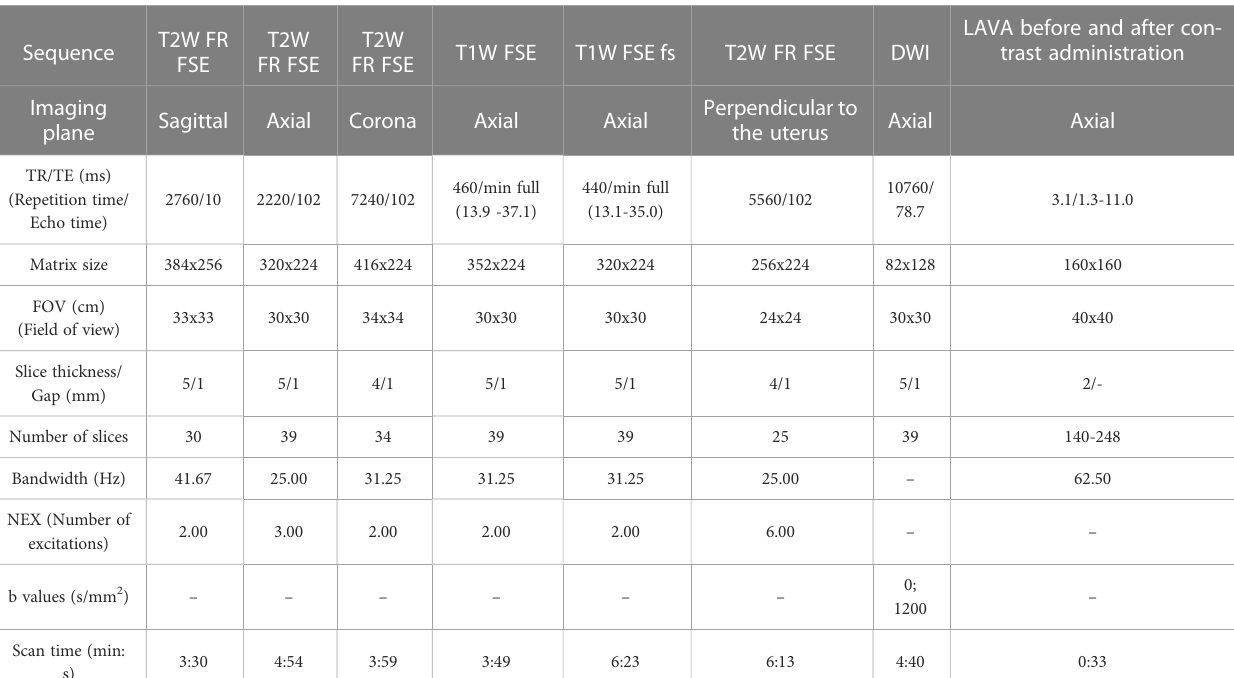
TABLE 1 Parameters of MRI sequences for pelvis examination.